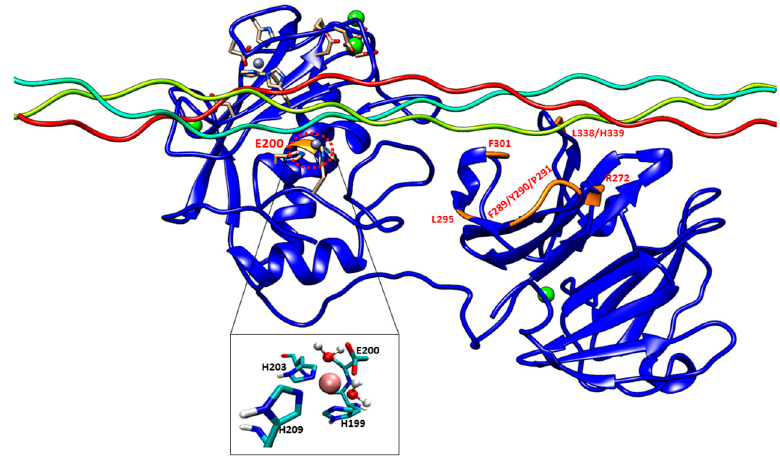
Figure 1. The 3D structure of inactive human matrix metalloproteinase-1 (MMP-1) (E200A mutant) complexed with a triple-helical peptide (THP) (PDB code: 4AUO [7]) drawn using UCSF Chimera [17]. MMP-1 consists of the catalytic (CAT) domain, inter-domain linker, and hemopexin-like (HPX) domain displayed in silhouette round ribbon representation. The THP leading, middle, and trailing strands are shown in tube representation in cyan, green, and red, respectively. The Zn 2+ and Ca 2+ ions bound to the enzyme are shown in spherical representation in ice blue and green, respectively. The mutations are shown in orange on the MMP-1 • THP structure. The snapshot of the active site of the MMP-1 • THP was obtained from molecular dynamics (MD) simulation [11]. The red dotted circle represents the location of the active site in MMP-1. The two solvent molecules are coordinated to the Zn 2+ along with three His residues with average distance maintained to the X-ray crystallographic distance using harmonic restraints in the simulation.